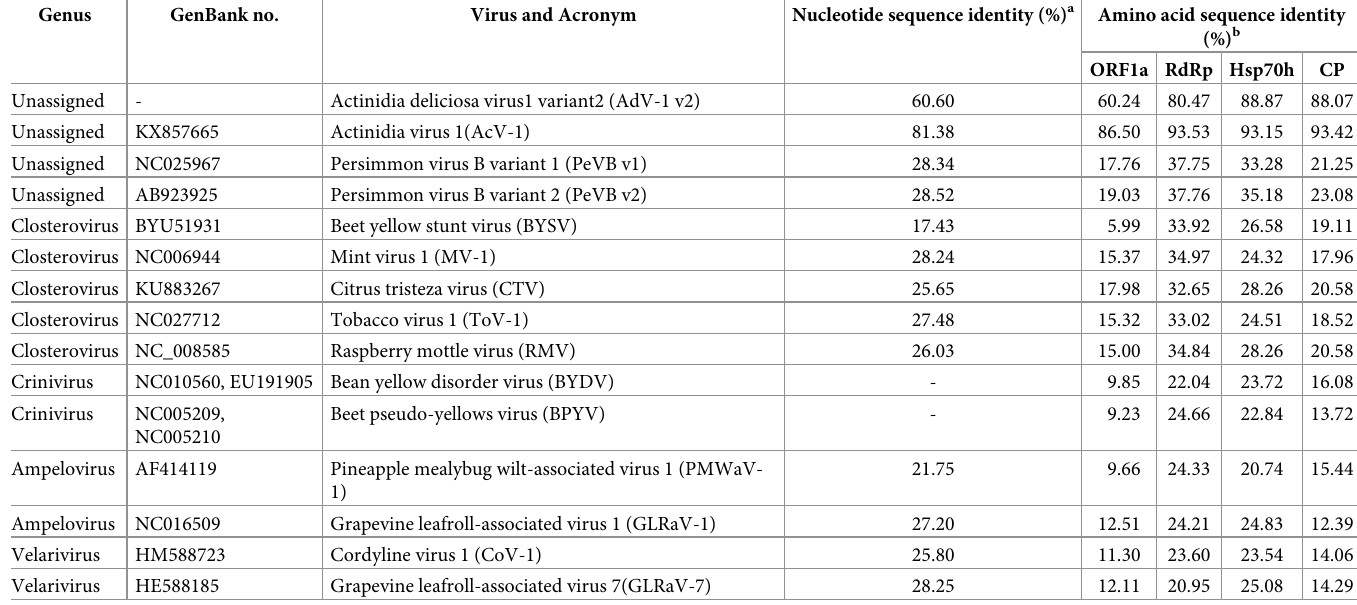
Table 2. Sequence identities of Actinidia deliciosa virus 1 variant 1 and 2 with other members of the family Closteroviridae . Genus GenBank